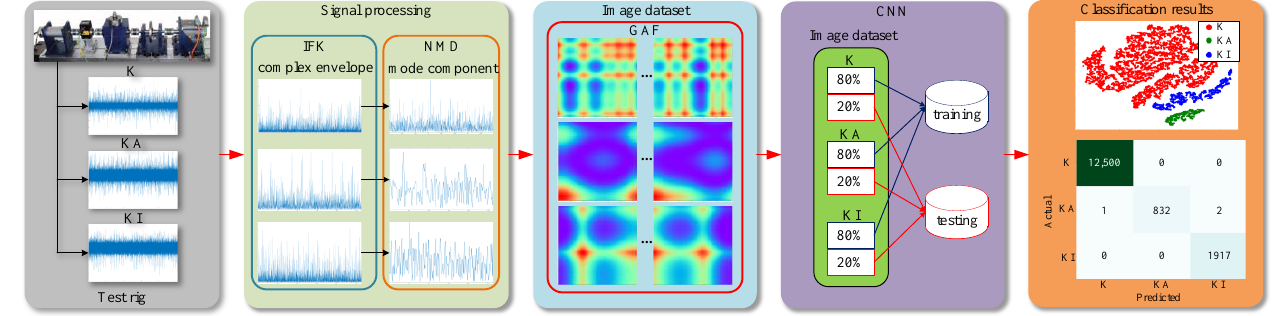
Figure 3. Illustration of a fault diagnosis model.